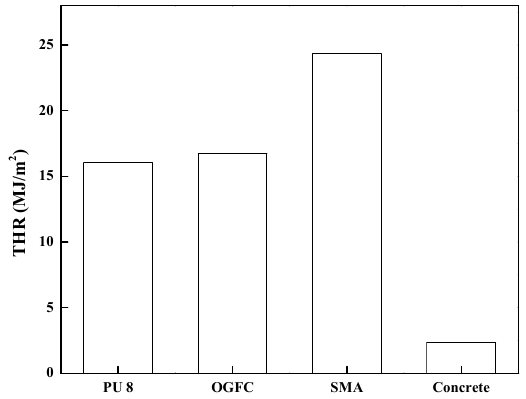
Figure 12. Comparison of total heat release (THR) among PU, OGFC and SMA.